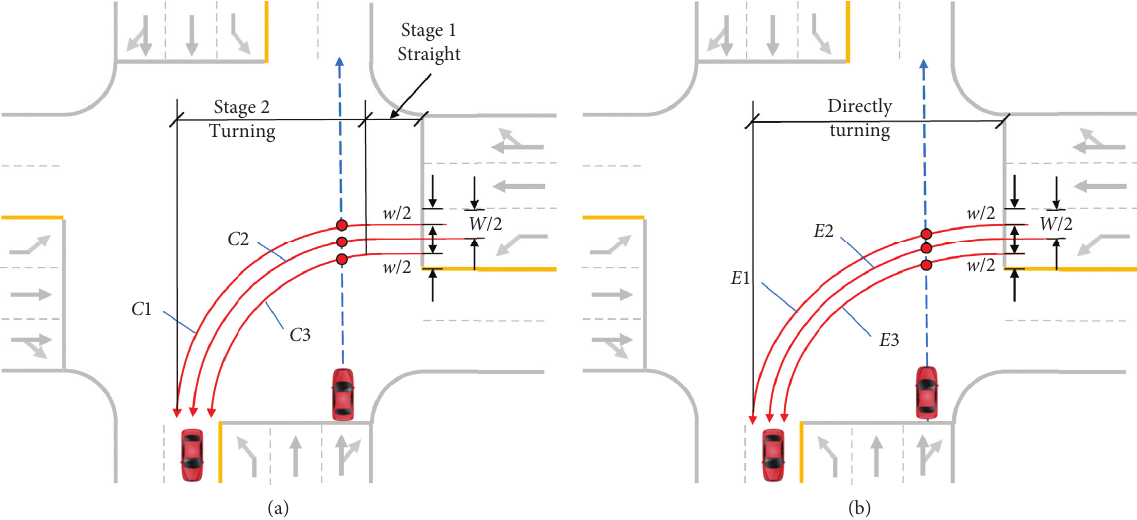
Figure 3: Typical left-turn paths. (a) Two-stage left-turn paths. (b) One-stage left-turn paths.